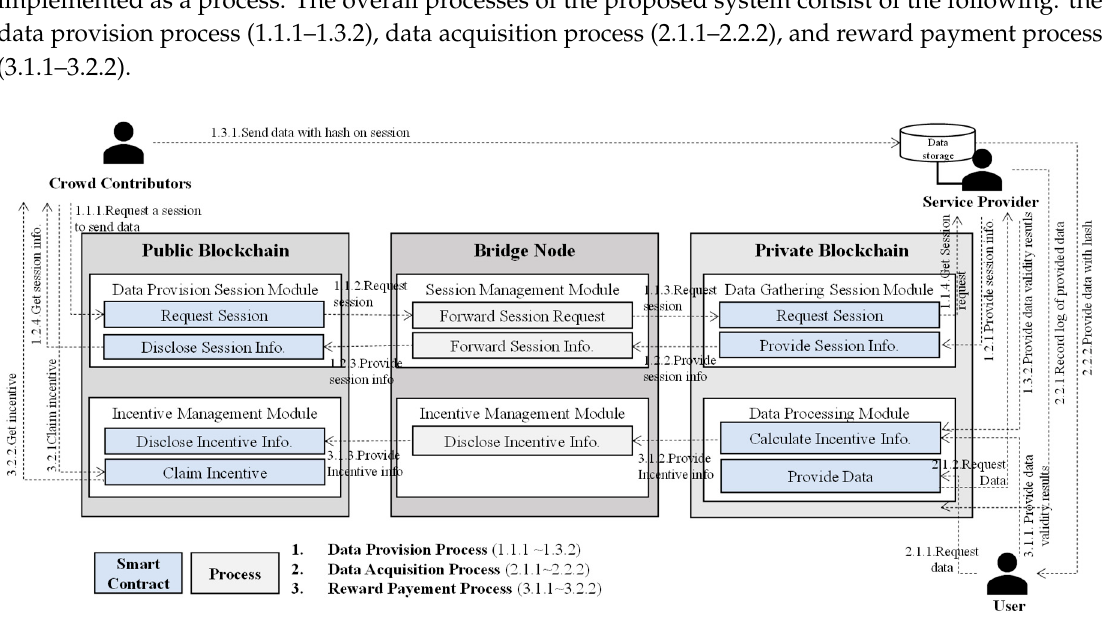
Figure 3. Functional modules and data flow of the proposed system.